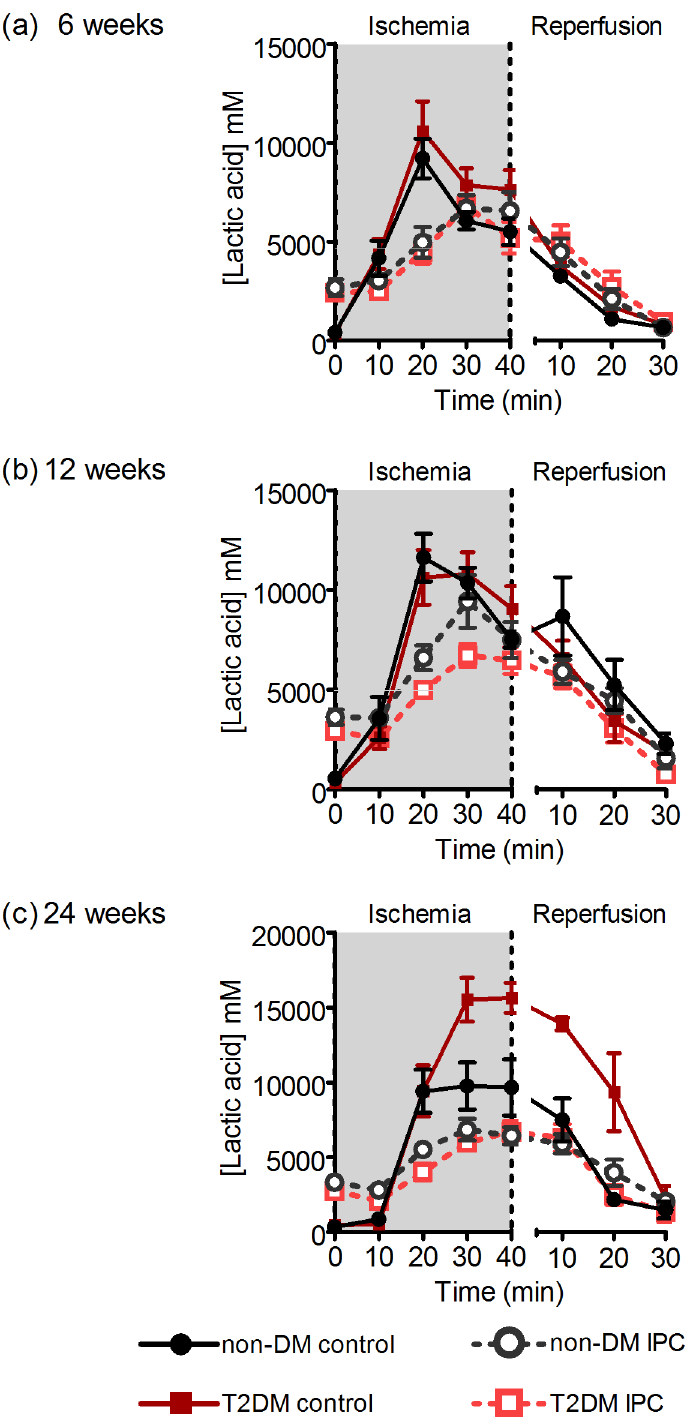
Fig 4. Interstitial lactate concentrations. Interstitial concentrations of lactate during ischemia and reperfusion in 6- (a), 12- (b), and 24-week-old (c) non-DM rats (heterozygote (fa/+)) and DM ZDF rats (homozygote (fa/fa)) after control or IPC-treatment. Data are mean ± SEM (n =